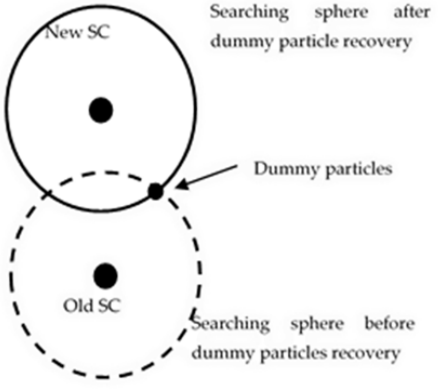
Figure A3. Dummy particle